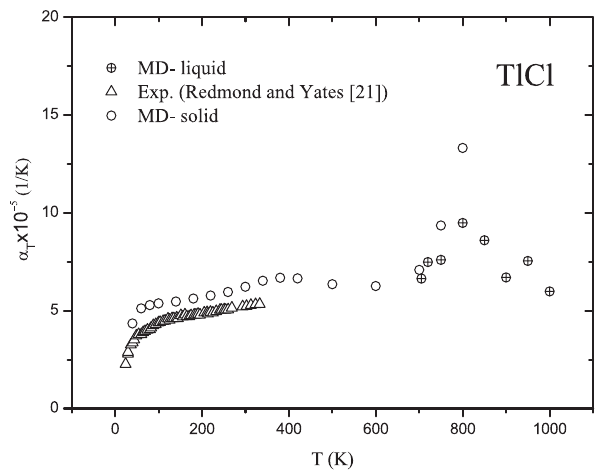
Fig. 1: Variation of lattice parameters with temperature for TlCl and TlBr.